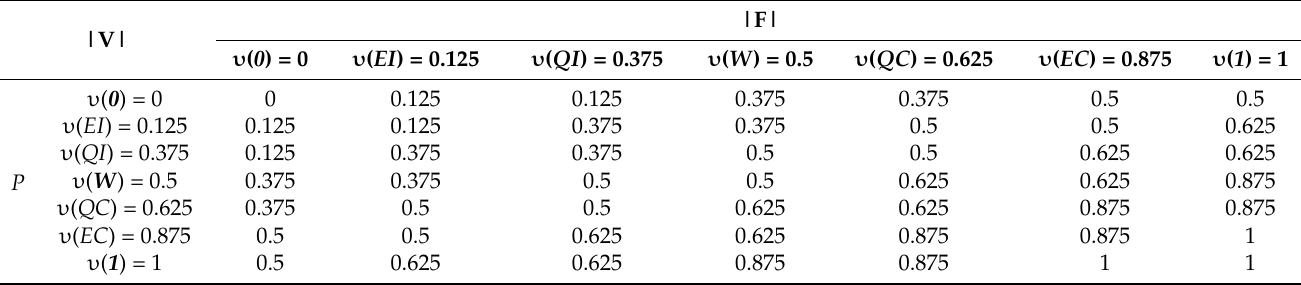
Table 6. The semantic relationship-based rule base of | V |.